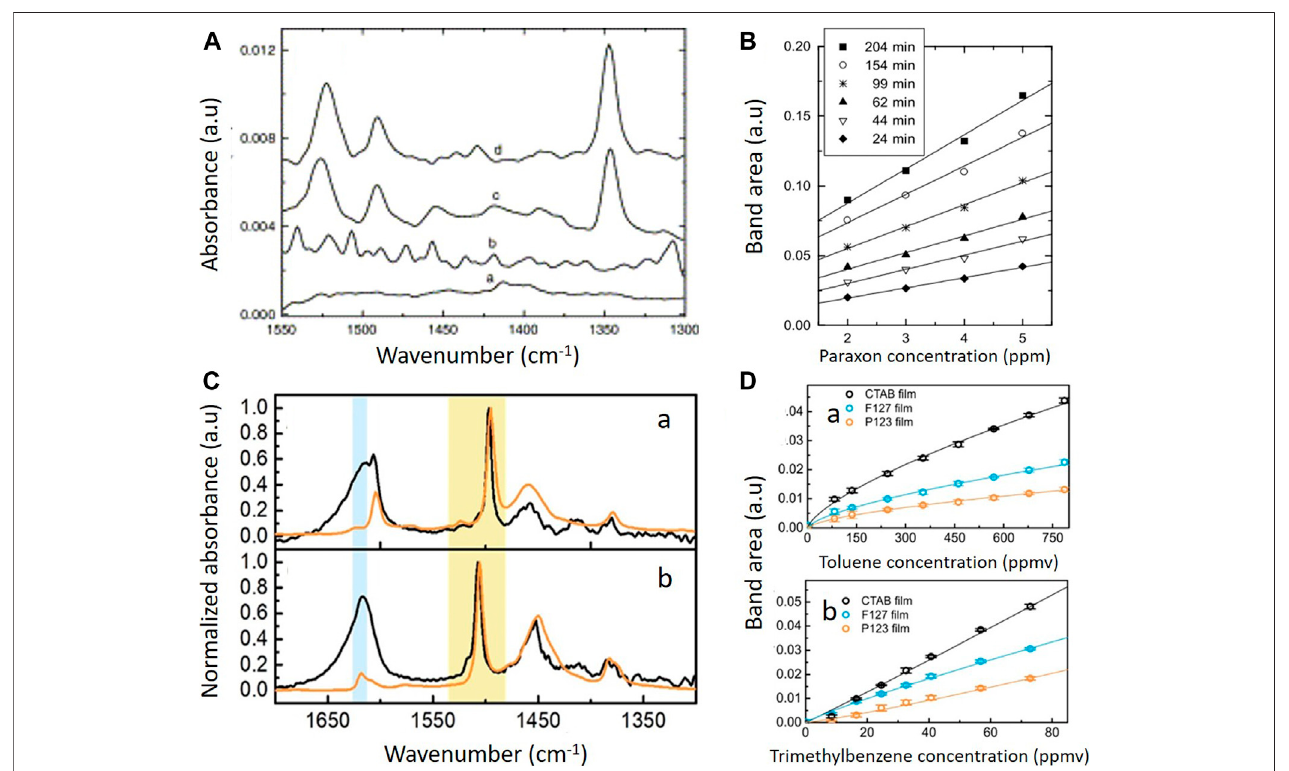
FIGURE 5 | A) Response produced after 60 min by ZnSe waveguide sensors mounted in a fl ow-through cell to the organophosphate parathion.: (a) uncoated waveguide purged with 2.5 ppm parathion; (b) a Te fl on AF coated waveguide purged with 2.5 ppm parathion; (c) uncoated waveguide purged with 40 ppm parathion; (d) sol – gel coated waveguide purged with 2.5 ppm parathion. (B) Calibration curve of paraoxon over the concentration range of 2 – 5 ppm evaluated at different times during the absorption process. Reprinted from Janotta et al. (2003b), Copyright (2003), with permission from Elsevier. (C) FTIR spectra (normalized to a peak absorbance of 1 of toluene (a) , and 1,2,4-trimethylbenzene (b) obtained after enrichment into the mesoporous silica fi lm synthesized using CTAB (black curves) and for the pure substance on a commercial ATR unit (orange spectra). Bands of adsorbed water are highlighted in blue and the spectral region of interest with skeletal ring vibrationsoftolueneat1,496 cm − 1 and 1,2,4-trimethylbenzene at 1,506 cm − 1 is highlighted in yellow. (D) Adsorption isotherms of different mesoporous fi lms for (a) toluene, and (b) 1,2,4-trimethylbenzene. Reprinted from Baumgartner et al. (2020b), Copyright (2020), with permission from